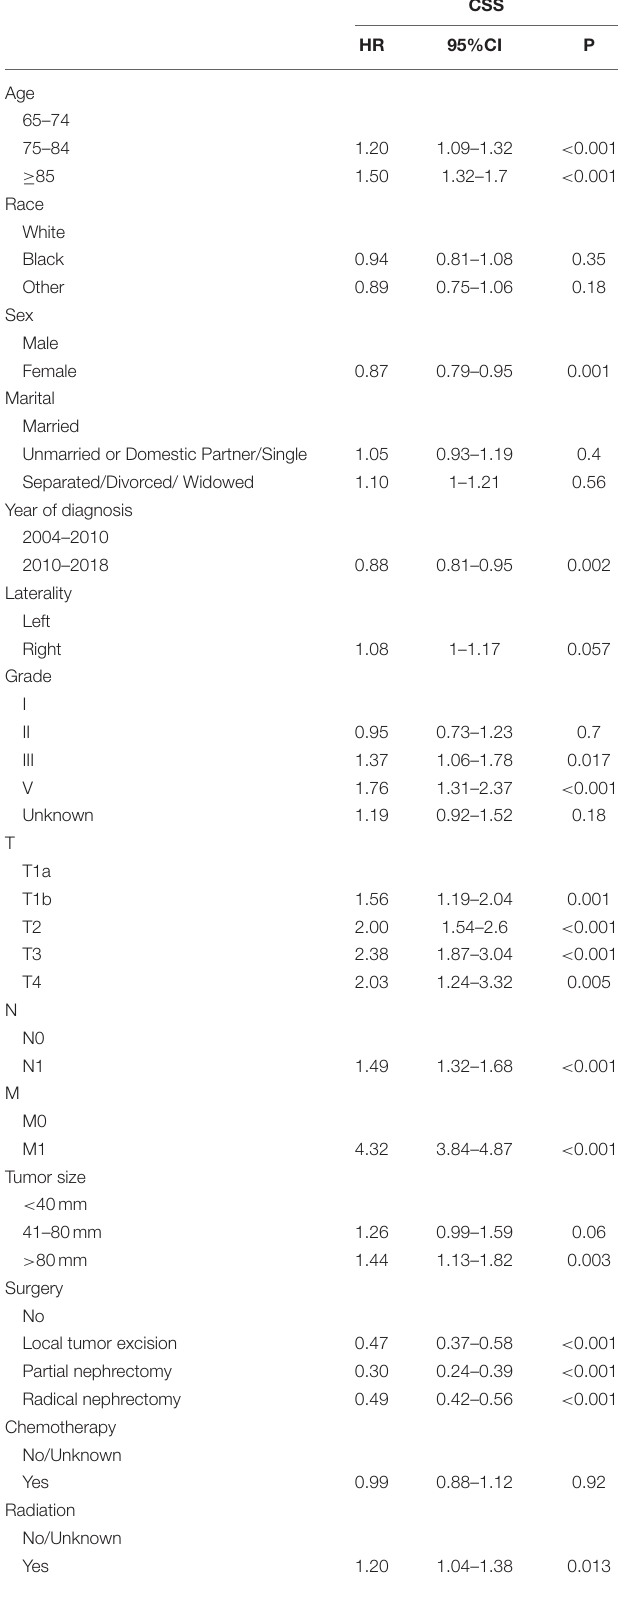
TABLE 2 | Proportional subdistribution hazard analyses of CSS in training